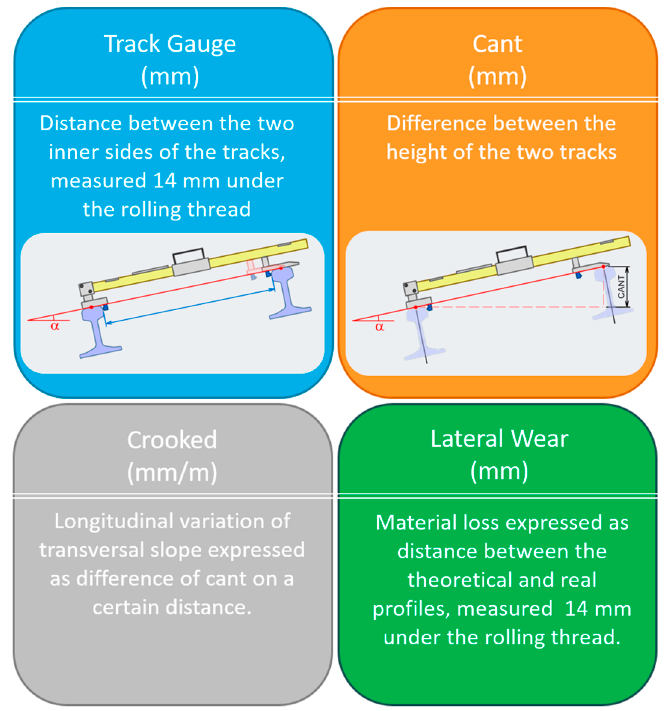
Figure 10. Geometric parameters to be measured by automated trolleys.